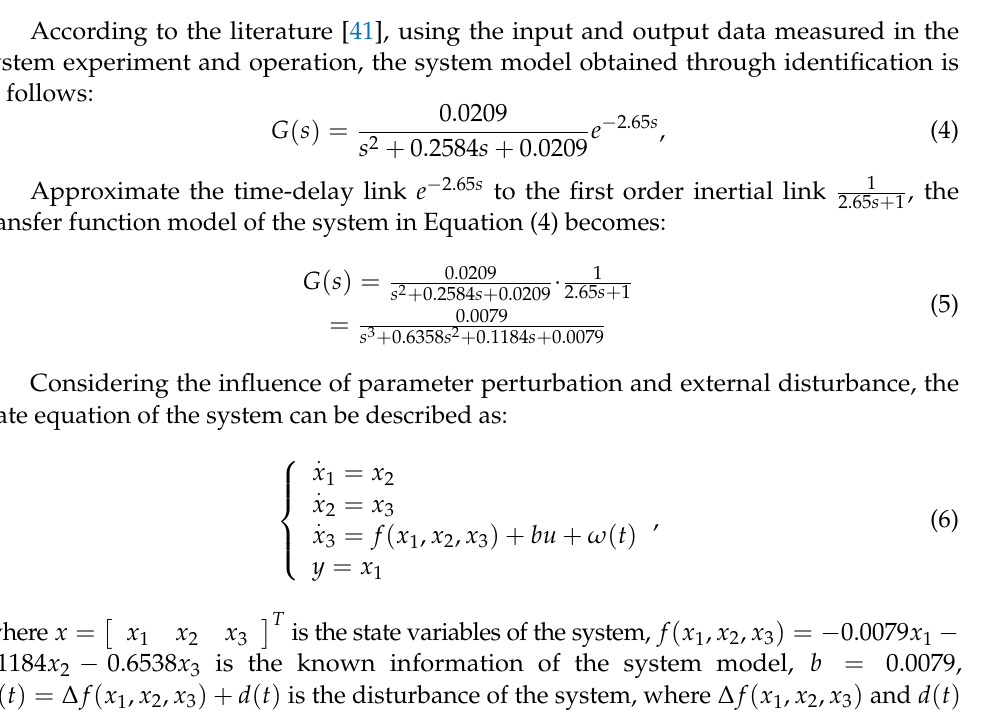
Figure 3. The particleboard glue control